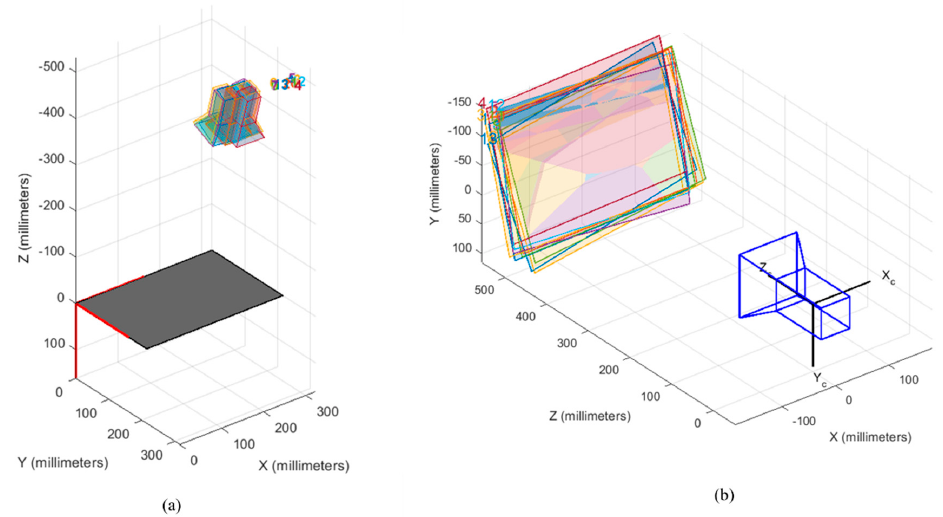
Figure 2. ( a ) Pattern Centric View of Eye-to-Hand Calibration ( b ) Camera Centric View of Eye-to- Hand Calibration . Once the calibration was completed, the camera frames were captured, and the RGB image was converted to grayscale and a particular channel, namely green, blue, and red channels, were extracted from the RGB data using the image subtraction technique where pixel values were subtracted to segment the particular part in the image. Once the single channel was extracted, 2D median filtering was applied to remove the salt and pepper noises present in the image and pads with zeros to preserve the edges. Further, the grayscale image was converted to black and white with the threshold values of 0.05, 0.18, and 0.1 for green (obstacles 1 and 2), red (goal), and blue (start) detection, respectively. Finally, image blob analysis was carried out to find the bounding box coordinates and centroid values of the objects in pixels. The process flow diagram for color-based detection using image processing is shown in Figure 3. Figure 3. Process Flow of Color Detection using Image Processing Techniques. Further the image coordinates needed to be converted to grid world coordinates; hence, in this work, a simple and robust technique called homogeneous coordinate